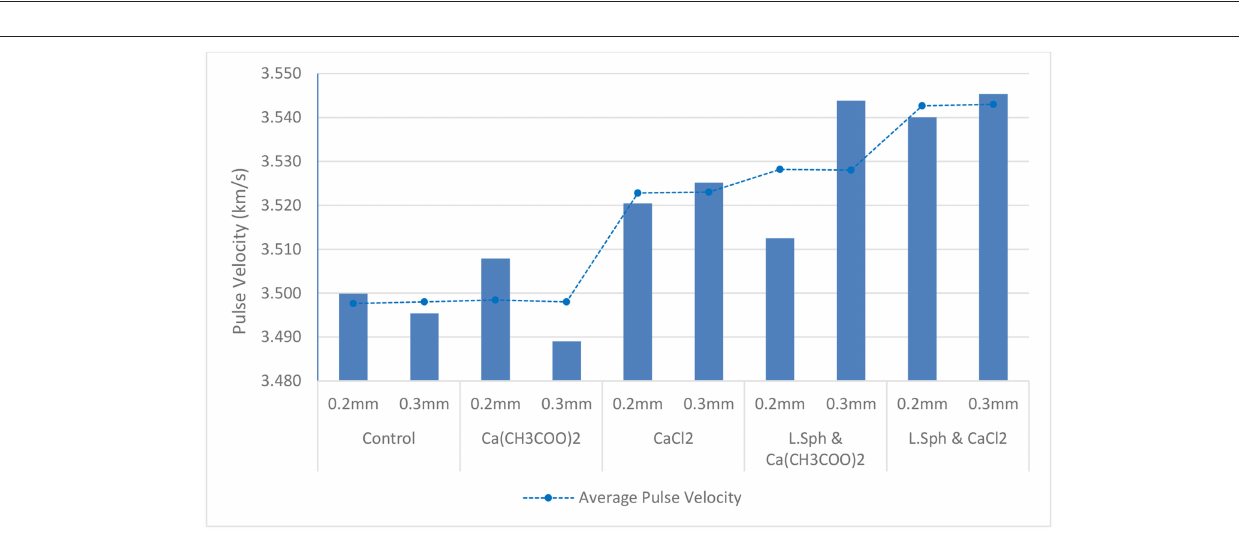
FIGURE 7 | Digital microscopy images of (a) untreated crack before treatment and (b) crack treated with L. sphaericus and Ca(CH 3 COO) 2 .